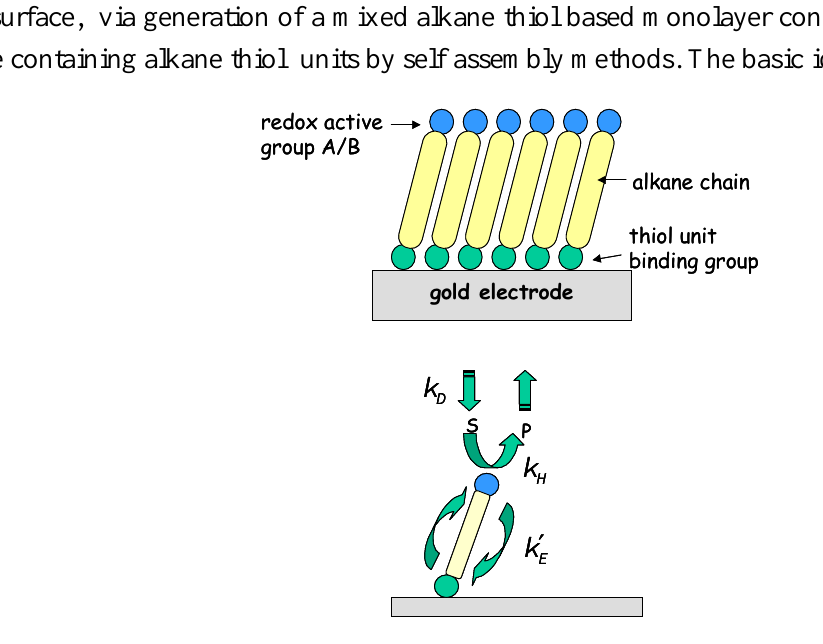
Figure 1 . Schematic representation of mediated electron transfer at an individual molecular